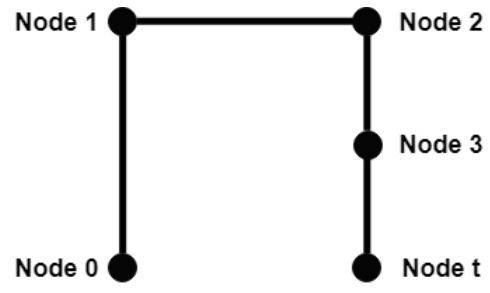
Figure 1. Five-node system in a distribution grid.